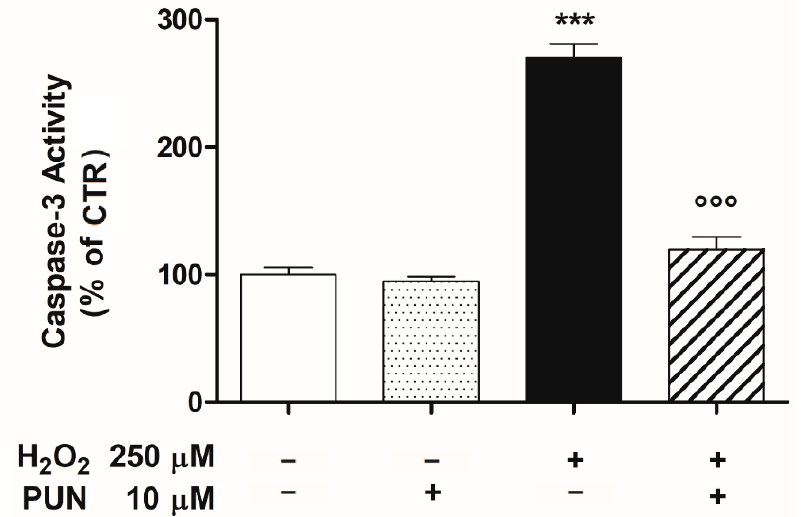
Figure 5. Pre–treatment with 10 µ M punicalagin (PUN) for 24 h downregulated the H 2 O 2 –induced caspase–3 activity in ARPE–19 cells. Data are expressed as a percentage relative to the untreated cells (control = 100%) and are presented as the means ± SEM of 6 replicates per group from two independent experiments. One–way ANOVA analysis was carried out followed by post hoc Newman–Keuls test. *** p < 0.001 vs. Control; °°° p < 0.001 vs. H 2 O 2 alone.